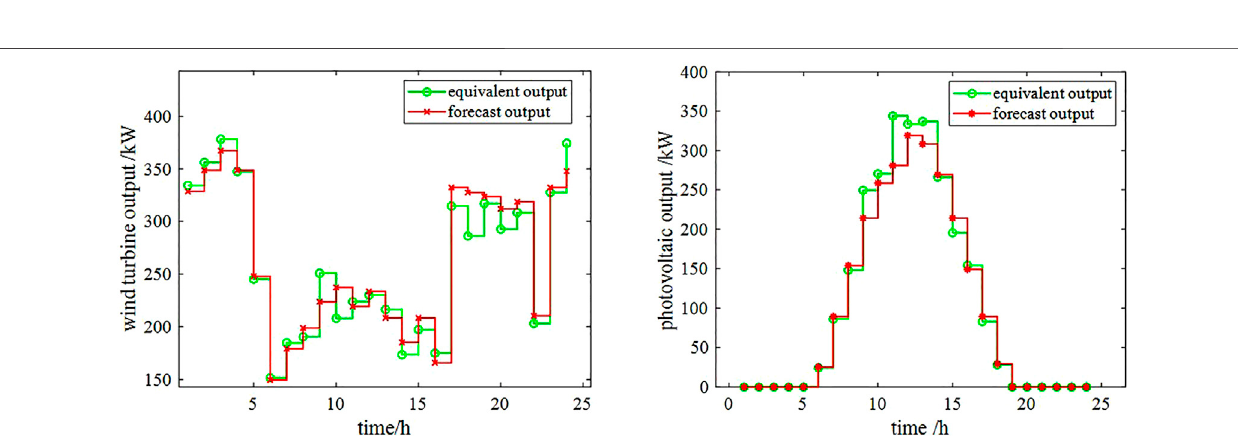
FIGURE 7 | Equivalent wind turbine (left) and photovoltaic unit (right) output curves in Case